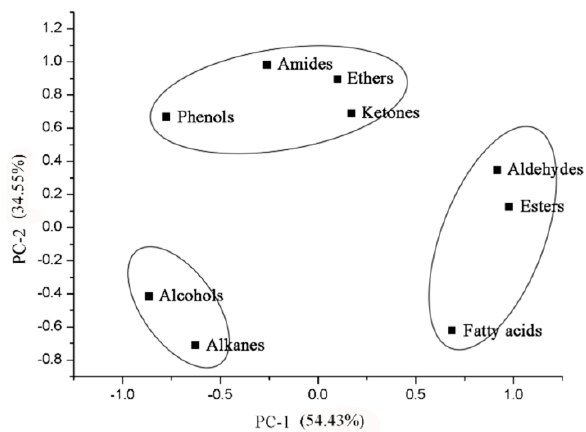
Figure 3. The principle components analysis (PCA) load diagram accorded to the relative concentrations of cuticle compounds in poplar leaves. Table 2. Linear regression analysis between the urediniospore germination and concentration of cuticle compounds.